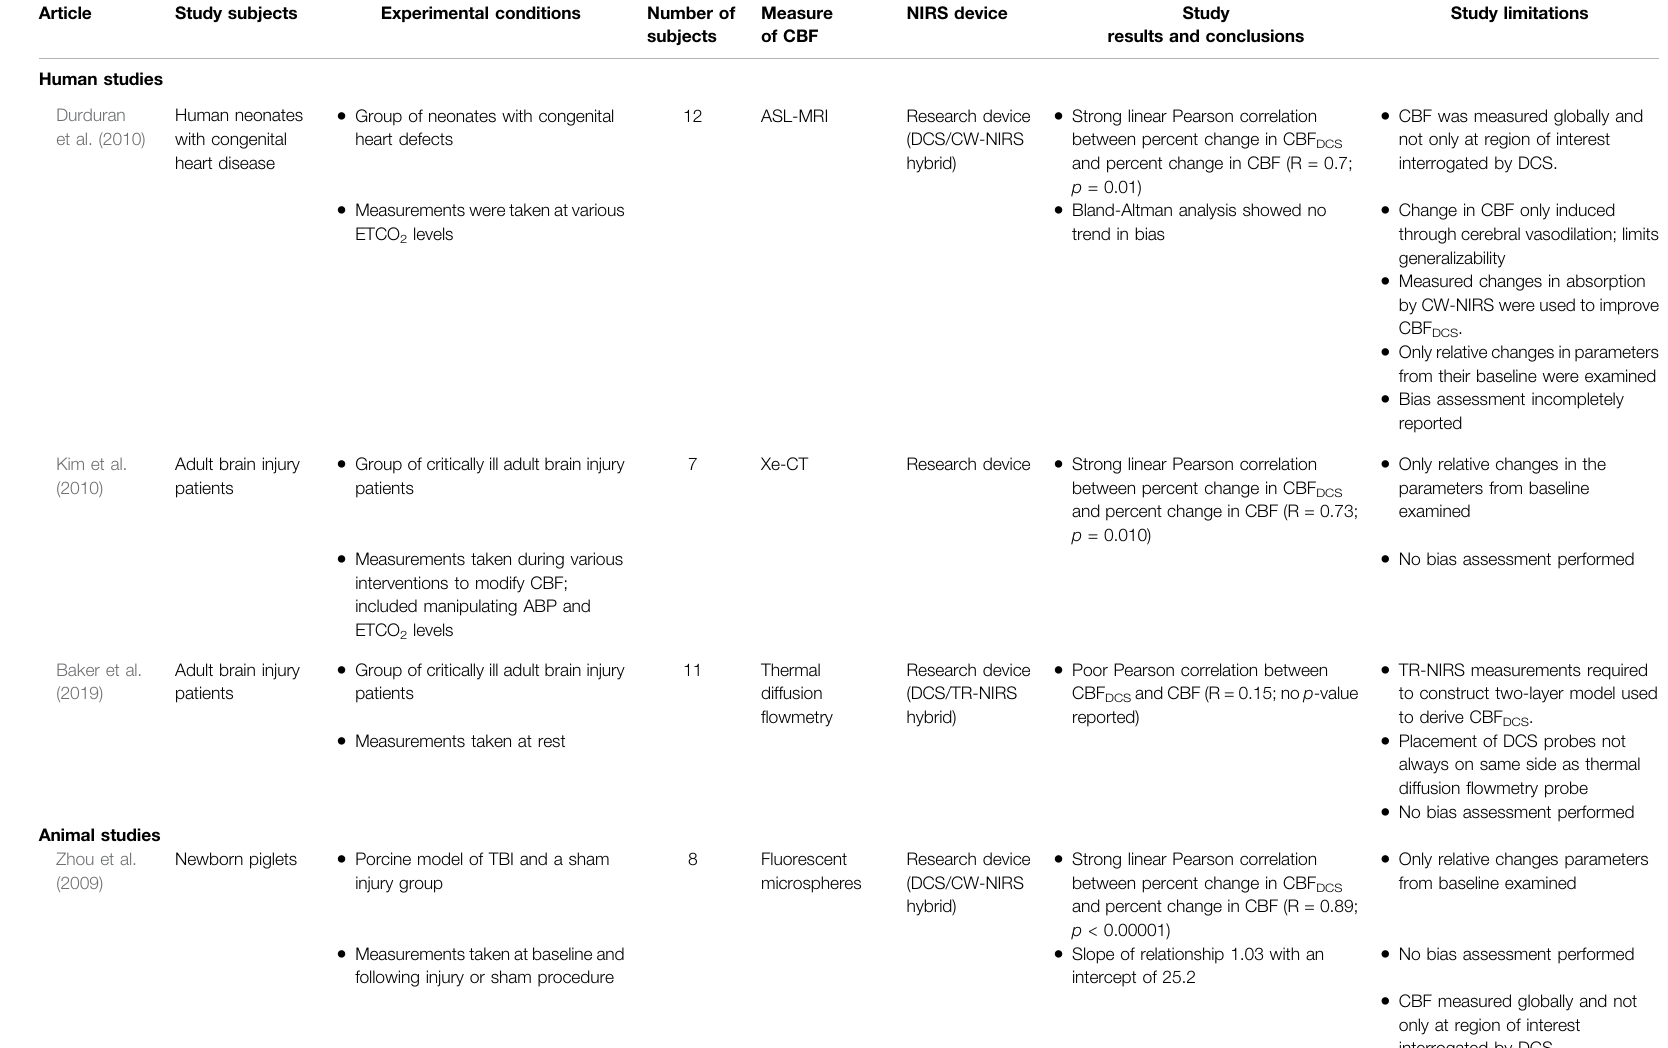
TABLE 3 | Summary of articles examining diffuse correlation spectroscopy (DCS) cerebrovascular